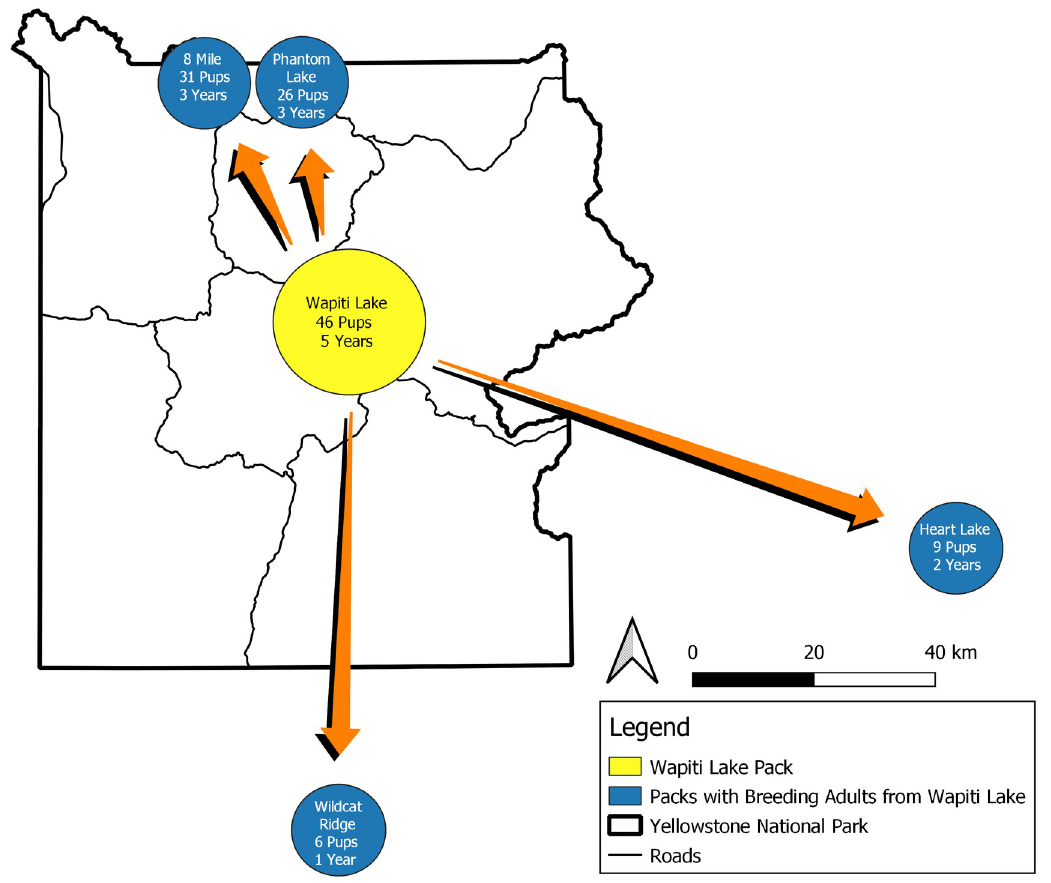
Fig 4. Resulting wolf pack map. Gray wolf packs in the Greater Yellowstone Ecosystem with breeding individuals descended from the Wapiti Lake pack after the displacement of dominant male 755M in the summer of 2016. As of 2021, at least four packs in the ecosystem had dominant breeding individuals that were descended from one of the Wapiti Lake females and one of the Mollie’s males. Pups produced post-displacement are listed in parenthesis below pack names. These numbers are cumulative pups from five years of reproductive effort